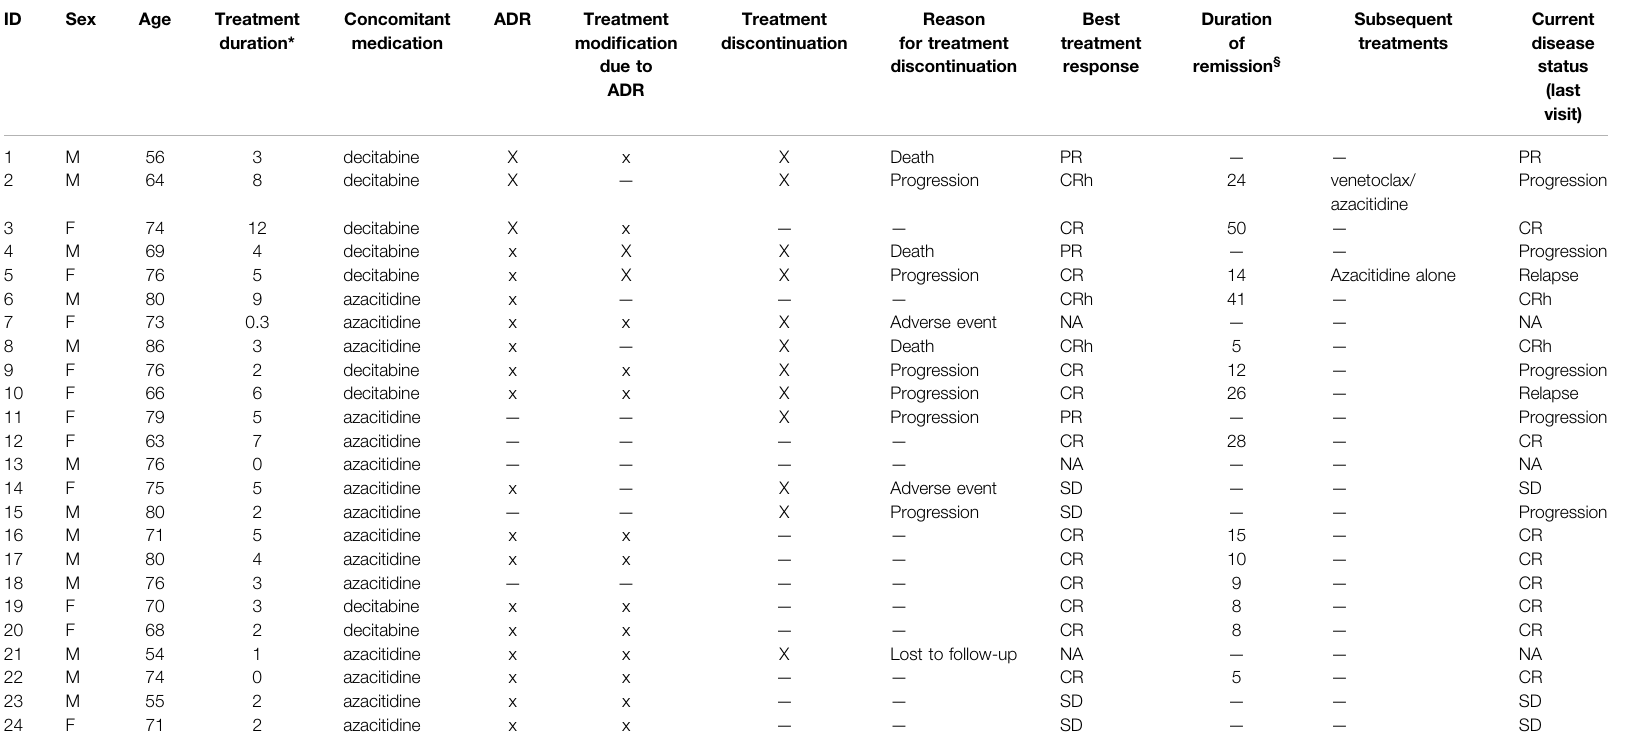
TABLE 2 | Treatment details and disease